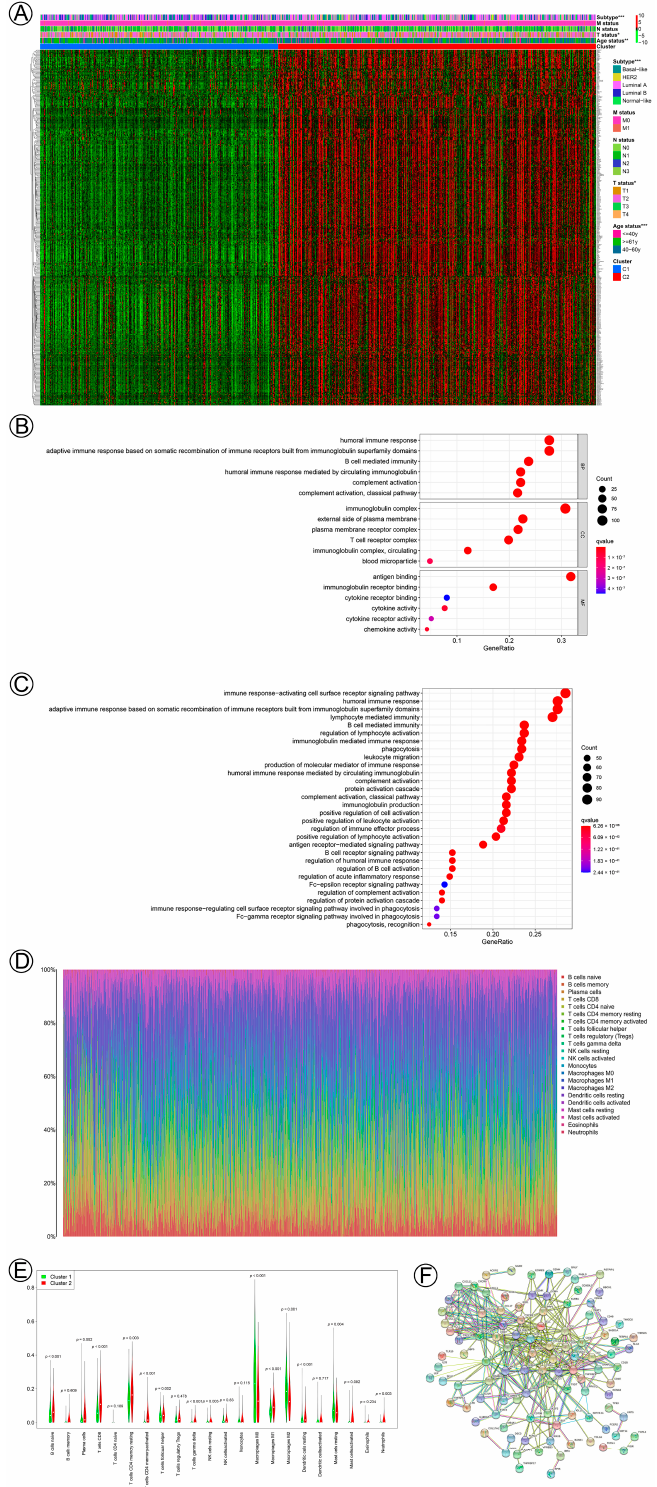
Figure 2. Biological functions and interactions of the differential gene expressions (DGEs) in the two pyroptosis-related clusters in BC. ( A ) A heatmap of the clinical relevance and DGEs (Fold change ≥ 1.5) of the two pyroptosis clusters. ( B ) Gene ontology (GO) annotation (biological process (BP), cellular component (CC), and molecular function (MF) of DGEs. ( C ) KEGG pathway analysis of DGEs. ( D ) Characterization of 22 types of immunocyte infiltration in breast cancer. ( E ) The proportion of immunocyte infiltration in the two pyroptosis-related clusters in breast cancer. ( F ) Protein–protein interaction network of DEGs. Notes: *, p < 0.05; **, p < 0.01; ***, p <